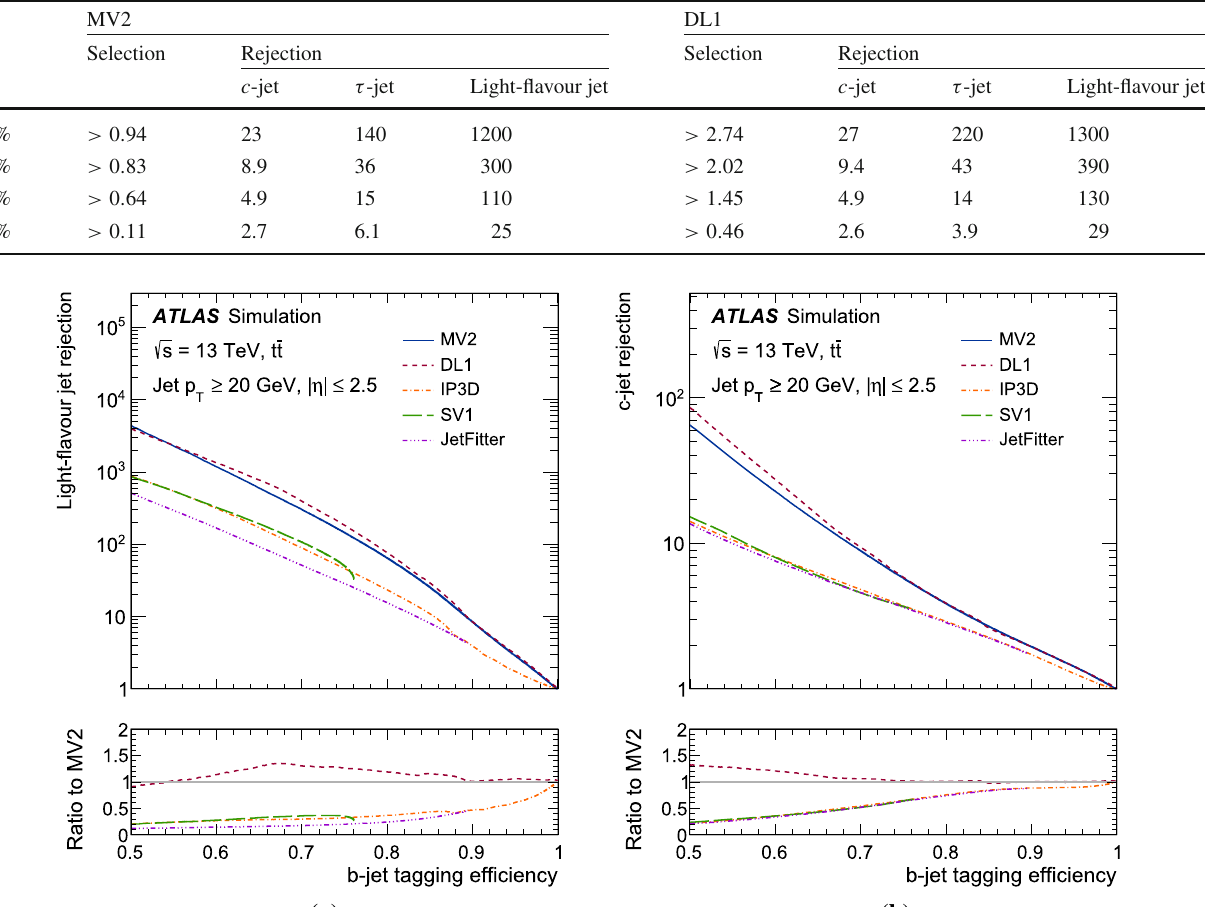
Table 4 Selection and c -jet, τ -jet and light-flavour jet rejections corresponding to the different b -jet tagging efficiency single-cut operating points for the MV2 and the DL1 b -tagging algorithms, evaluated on the baseline t ¯ t events